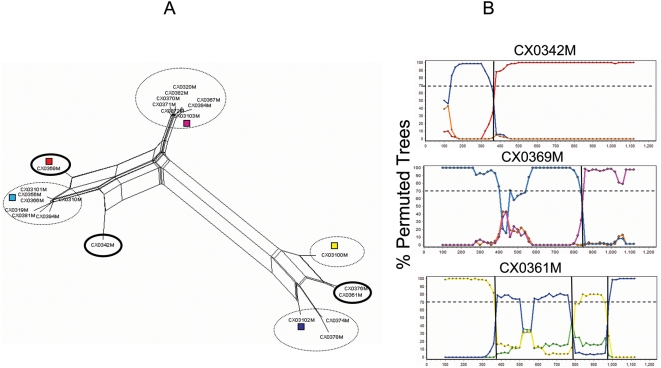
Recombination analysis of HIV-1 gp120 sequences from the meninges of subject CX.A. Neighbor-Net (NNet) obtained with the split-decomposition method and uncorrected p-distances for HIV-1 gp120 sequences amplified from meninges. Solid and broken circles highlight putative recombinant and parental sequences, respectively. A colored box indicates a monophyletic group of putative parental sequences to be tested in the bootscanning analysis B. Bootscanning plots of three recombinant sequences. Each bootscanning was carried out on an alignment that included a query sequence (the putative recombinant), and a set of putative parental sequences (indicated by different colors corresponding to the colored boxes in panel A. The query sequence (within the solid circles in panel A) is given at the top of each bootscanning plot. The x-axis represents the nucleotide position along the alignment; the y-axis represents the % bootstrap support for the clustering of the query sequences with one of the monophyletic groups in panel A. The crossing point between two lines of different color, indicated by a vertical solid line, specifies the assumed position of a recombination breakpoint.